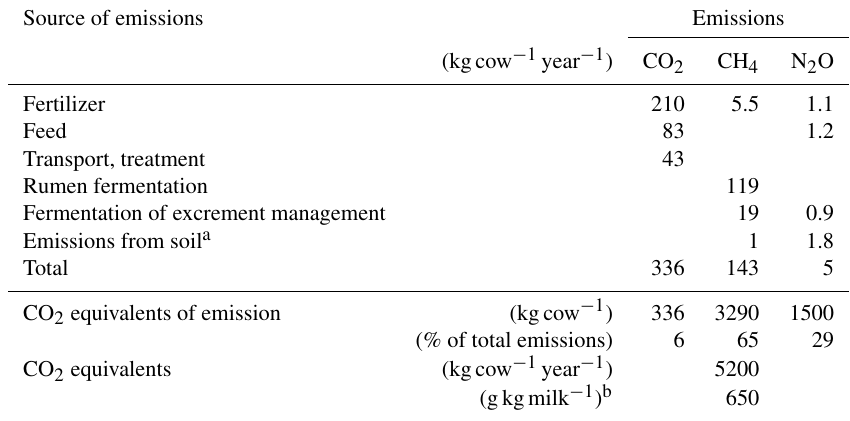
Table 14. Calculation of emissions per cow and year (650kg body weight, 8000kgmilkyear − 1 , one calf per year; Dämmgen and Haenel,